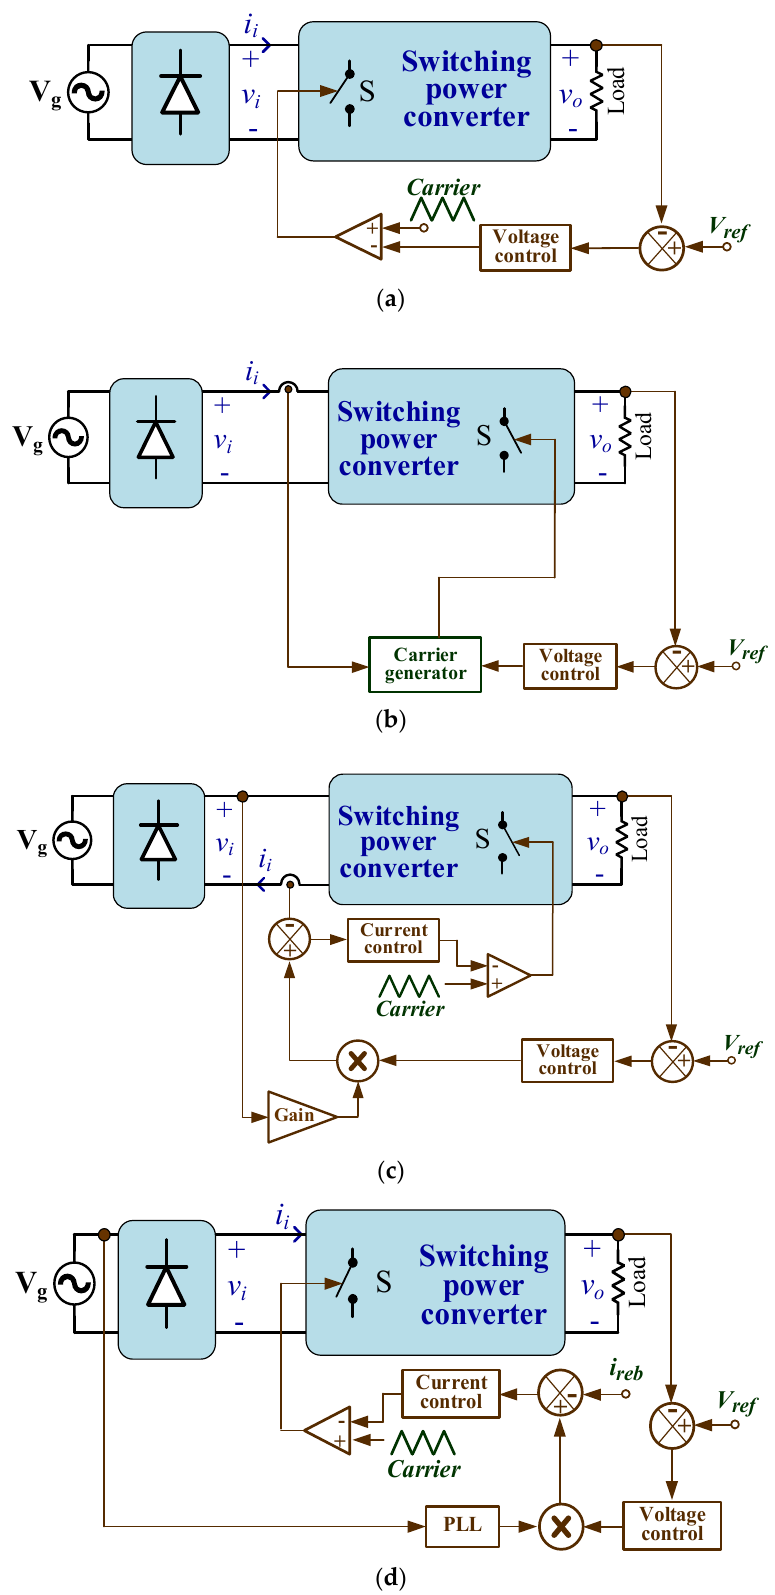
Figure 2. Types of current control techniques in PFCs. ( a ) Group I, ( b ) Group II, ( c ) Group III and ( d ) Group IV.